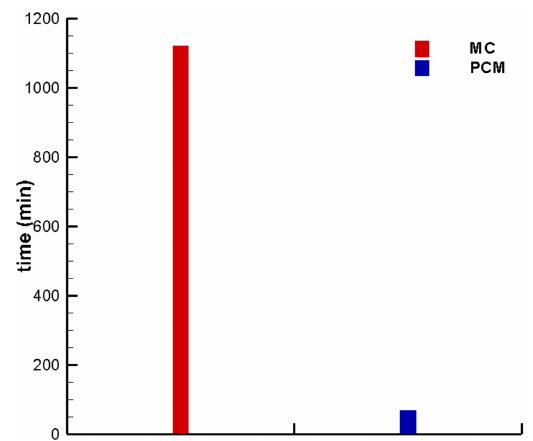
Figure 13. Computational time for MC- and PCM-based multimodel analysis